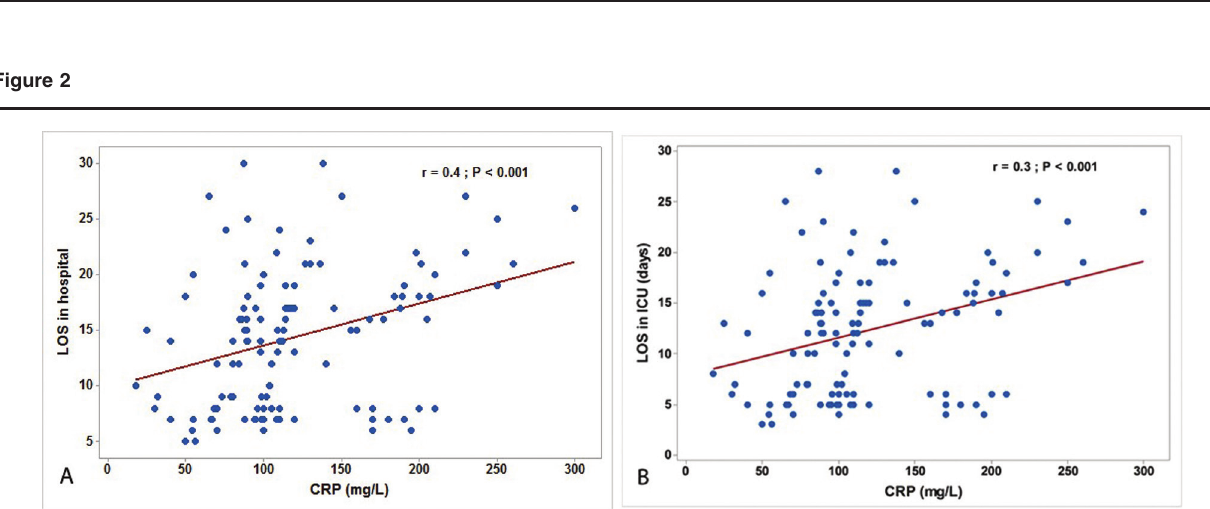
Eos% level in correlation with MV support need. *Mann – Whitney test, P < 0.05 considered significant. Eos, eosinophils; MV, mechanical ventilation.